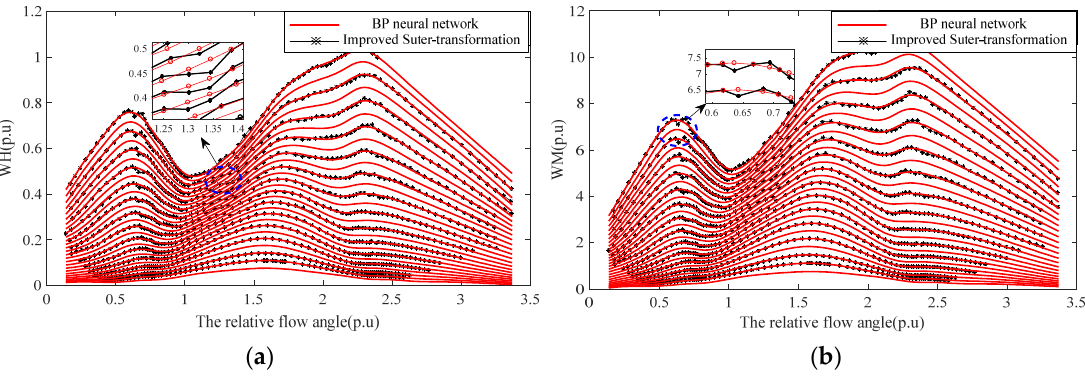
Figure 4. The characteristic pump-turbine curves after pretreatment. ( a ) The WH curves; ( b ) The WM curves.